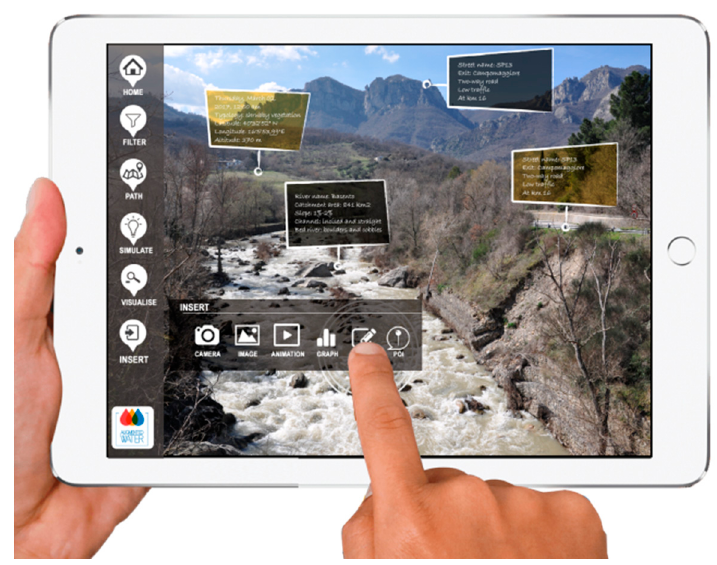
Figure 5. Application notes associated with some POIs.